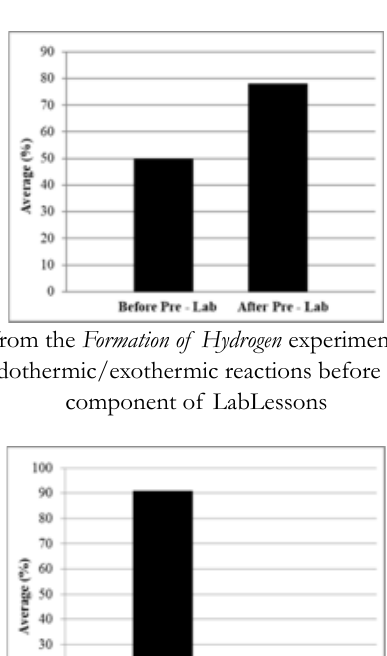
Figure 8. Responses from the Formation of Hydrogen experimental group on how well they understood the lab before and after the pre-lab component of LabLessons